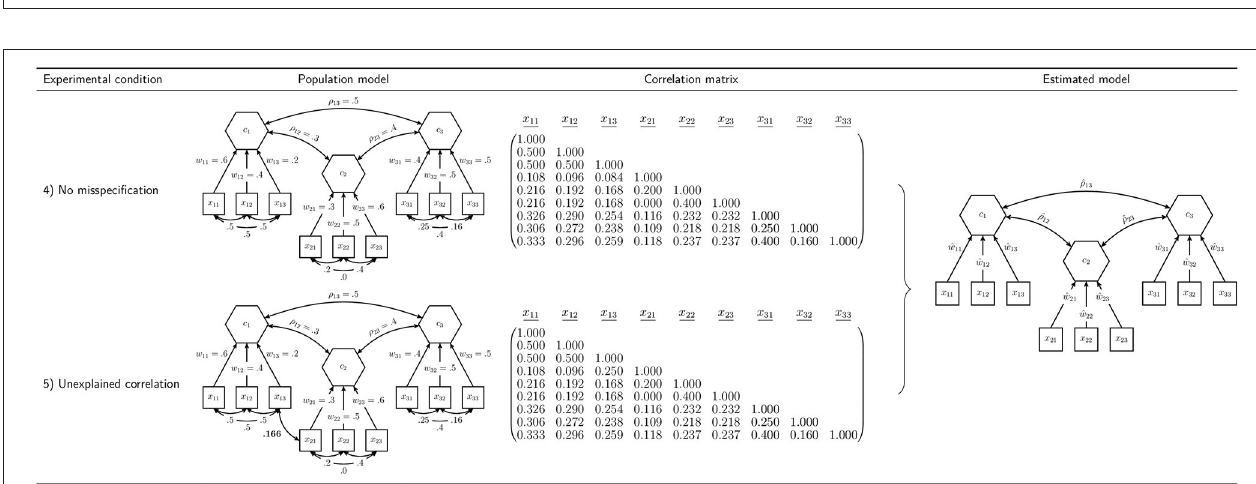
FIGURE 4 | Simulation design for the model containing two composites.